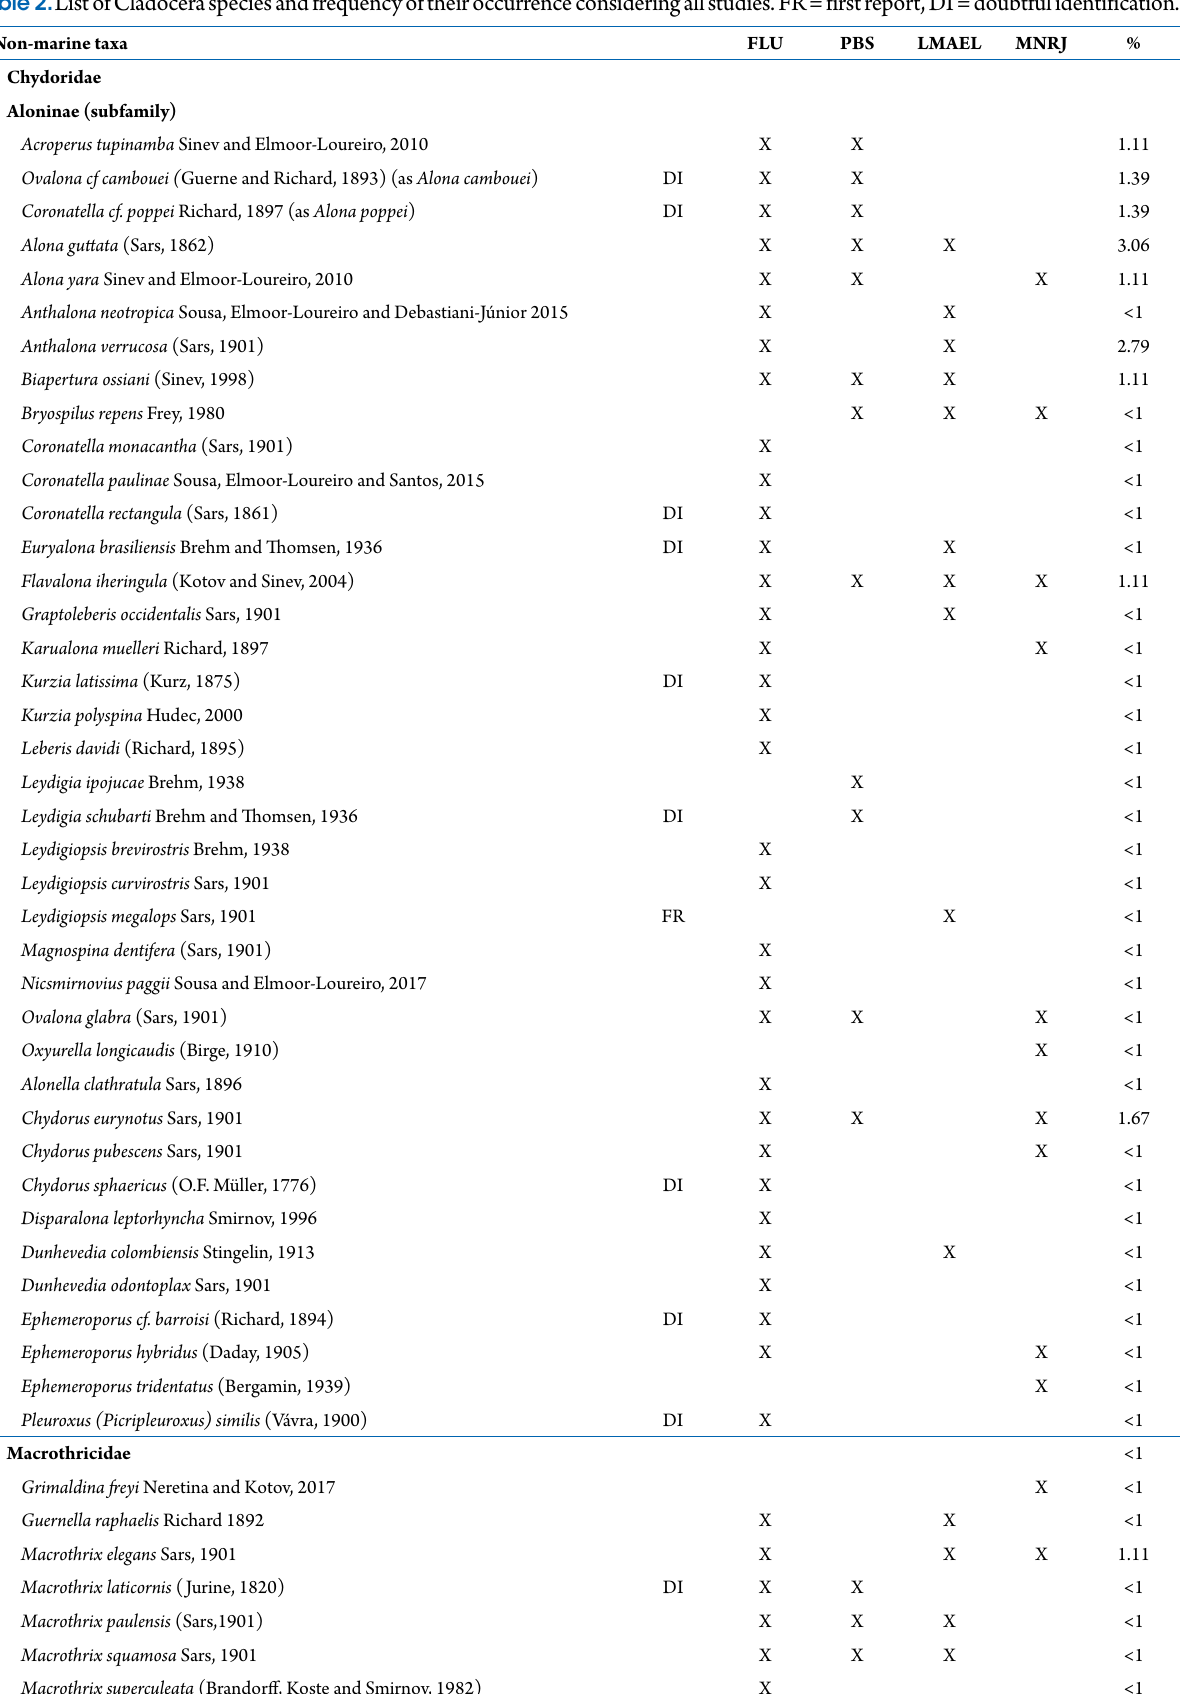
Table 2. List of Cladocera species and frequency of their occurrence considering all studies. FR = first report, DI = doubtful identification. Non-marine taxa FLU Chydoridae Aloninae